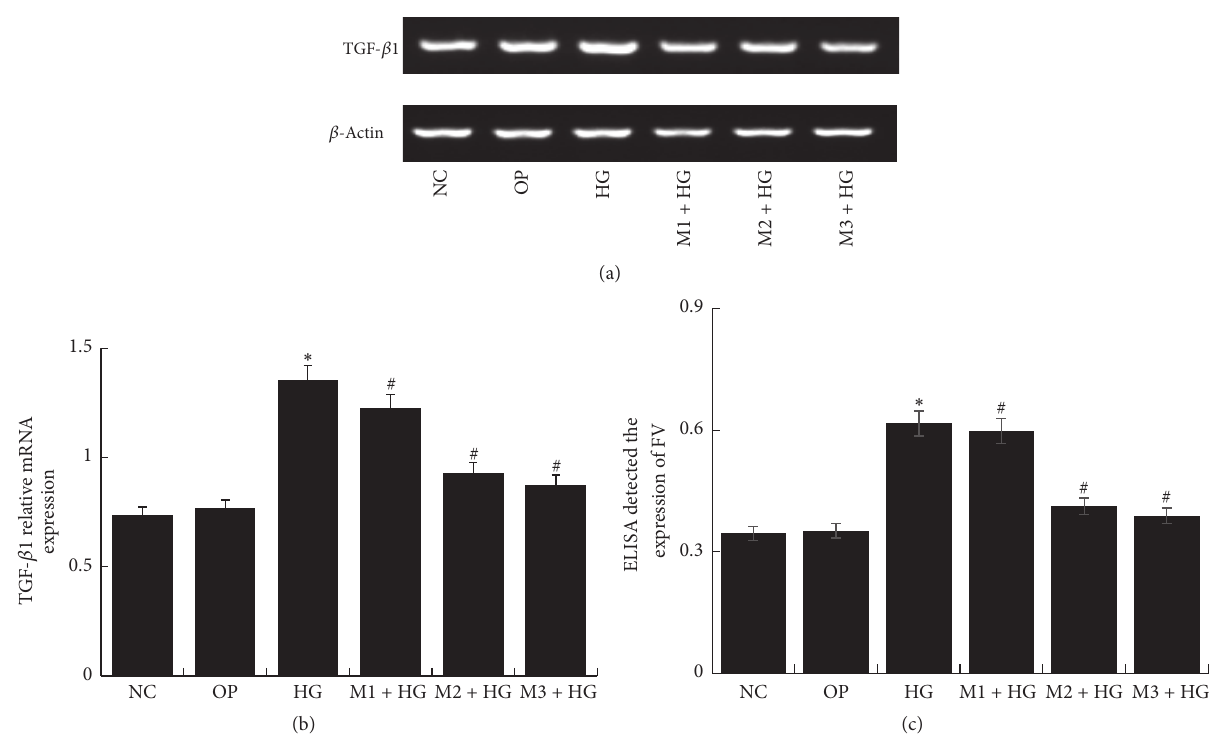
Figure 7: The expression of TGF- 𝛽 1 and FN in each group. (a) Expression of TGF- 𝛽 1 in GMCs which were treated with different does of maresin1for30 minandwereexposedtohighglucose(30 mmol/L)for48h.ComparedwithNCgroup,expressionofTGF- 𝛽 1wassignificantly increased in HG group, and compared with HG group, expression of TGF- 𝛽 1 was significantly lower in M + HG group, and there were effective changes in M2 + HG group. (b) The corresponding relative gray value statistics graph of the mRNA level. ∗ 𝑃 < 0.05 versus NC group, # 𝑃 < 0.05 versus HG group. (c) FN ELISA kit detected the level of FN in each supernatant of GMCs; we detected the similar change with TGF- 𝛽 1; ∗ 𝑃 < 0.05 versus NC group, # 𝑃 < 0.05 versus HG